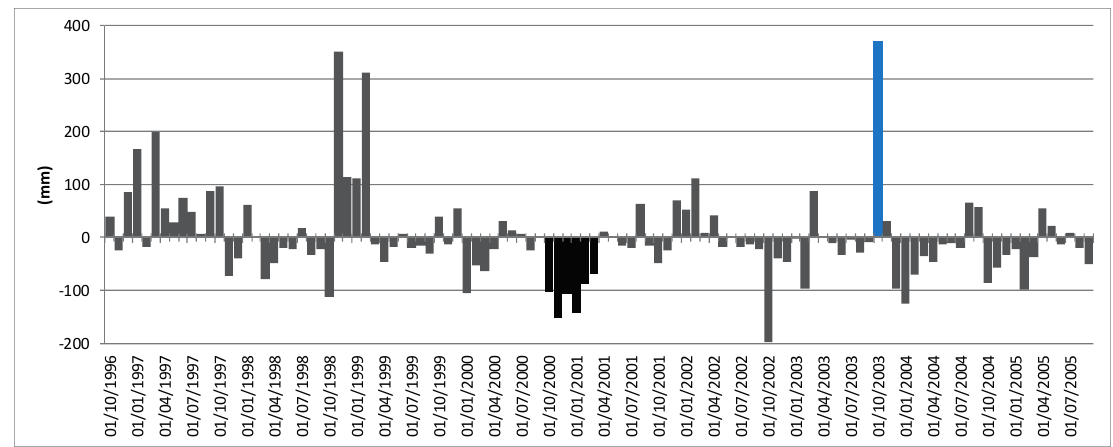
Figure 6. Divergence of monthly precipitation versus average precipitation for that month (grey), divergence in wet season with lowest precipitation (black) and largest divergence from monthly average value